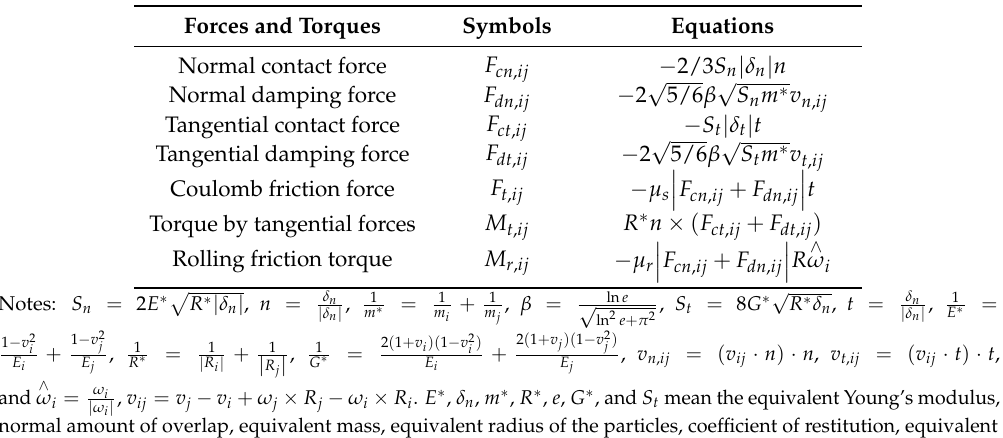
Table 2. Forces and torques acting on particles i .